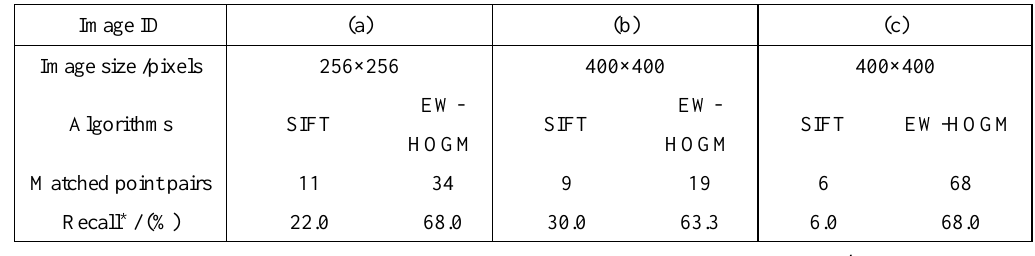
Table 1 Comparisons of SIFT and EW-HOGM